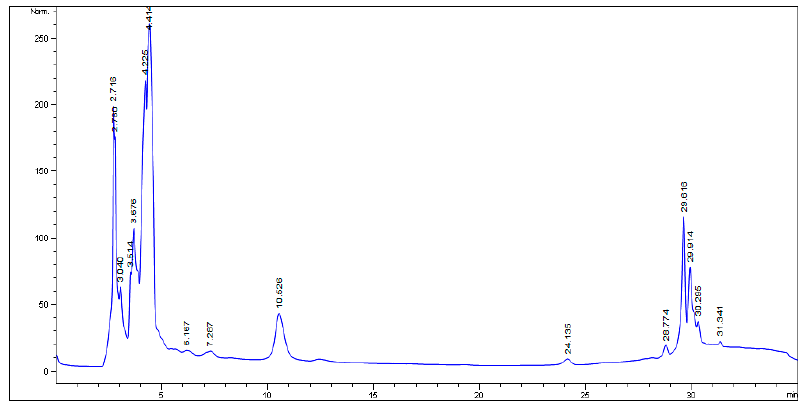
Parkia biglobosa protein